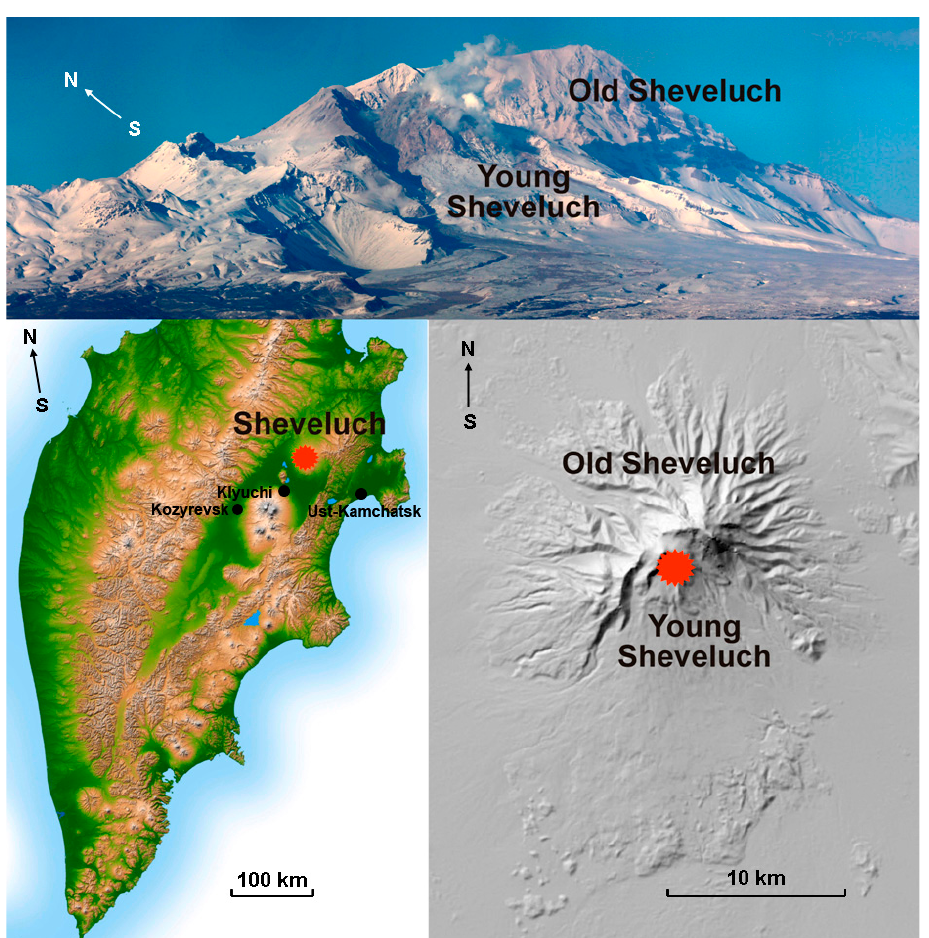
Figure 1. The Sheveluch volcano (Old and Young) at Kamchatka, Russia [40]. Sheveluch is located in the northwestern part of the 9 km caldera formed on the southern slope of the Old Sheveluch volcano during the late Pleistocene (~30 thousand 14 C years) [33,41]. The volcano was formed from a large number of merged andesitic extru-